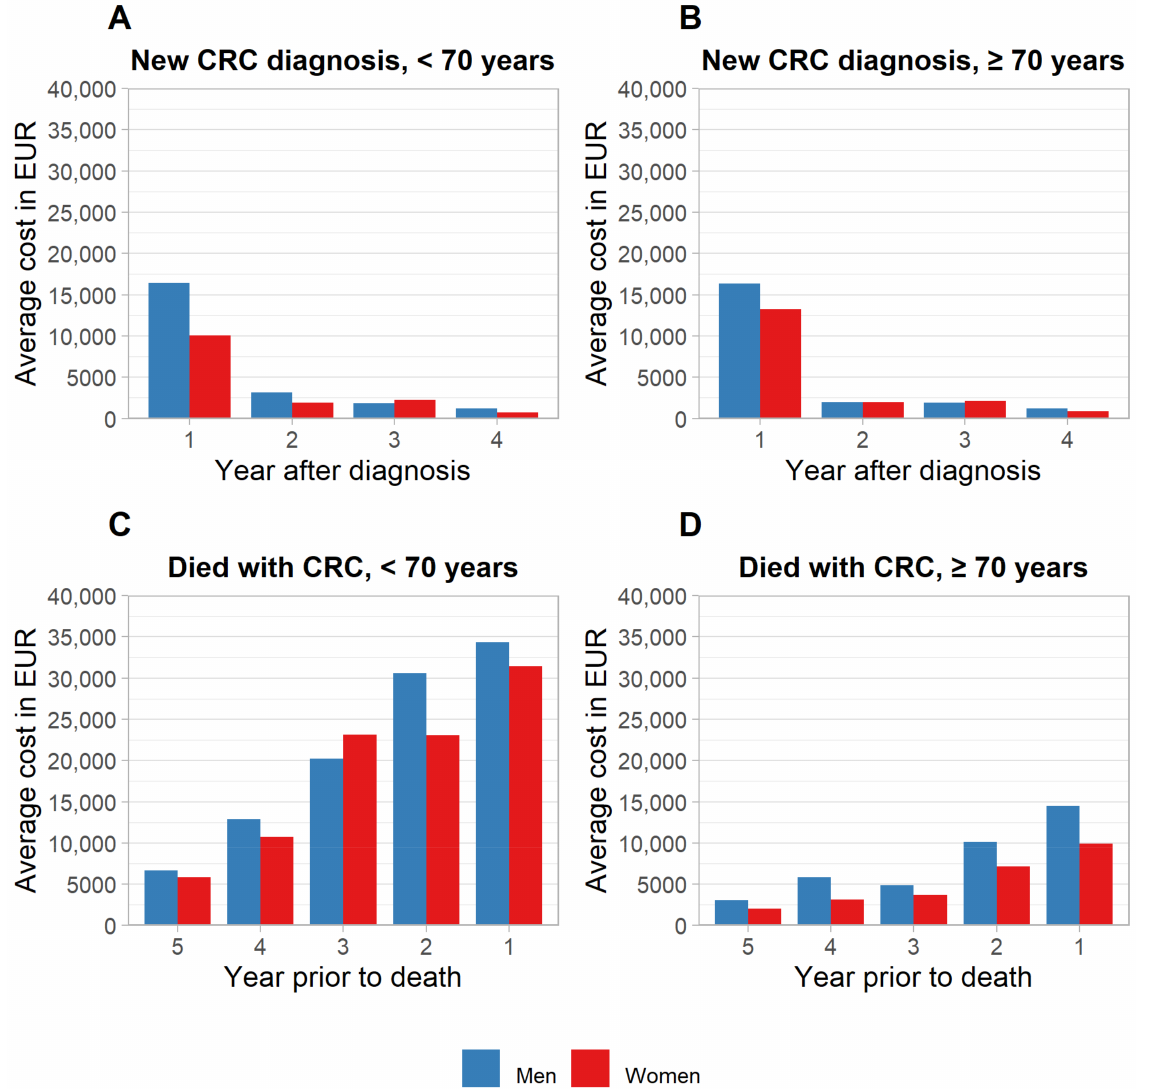
Figure 1. Average total treatment costs of colorectal cancer after new diagnosis and prior to death, stratified by sex and age. ( A , B ) Newly diagnosed cases. ( C , D ) Subjects who died of CRC. CRC, colorectal